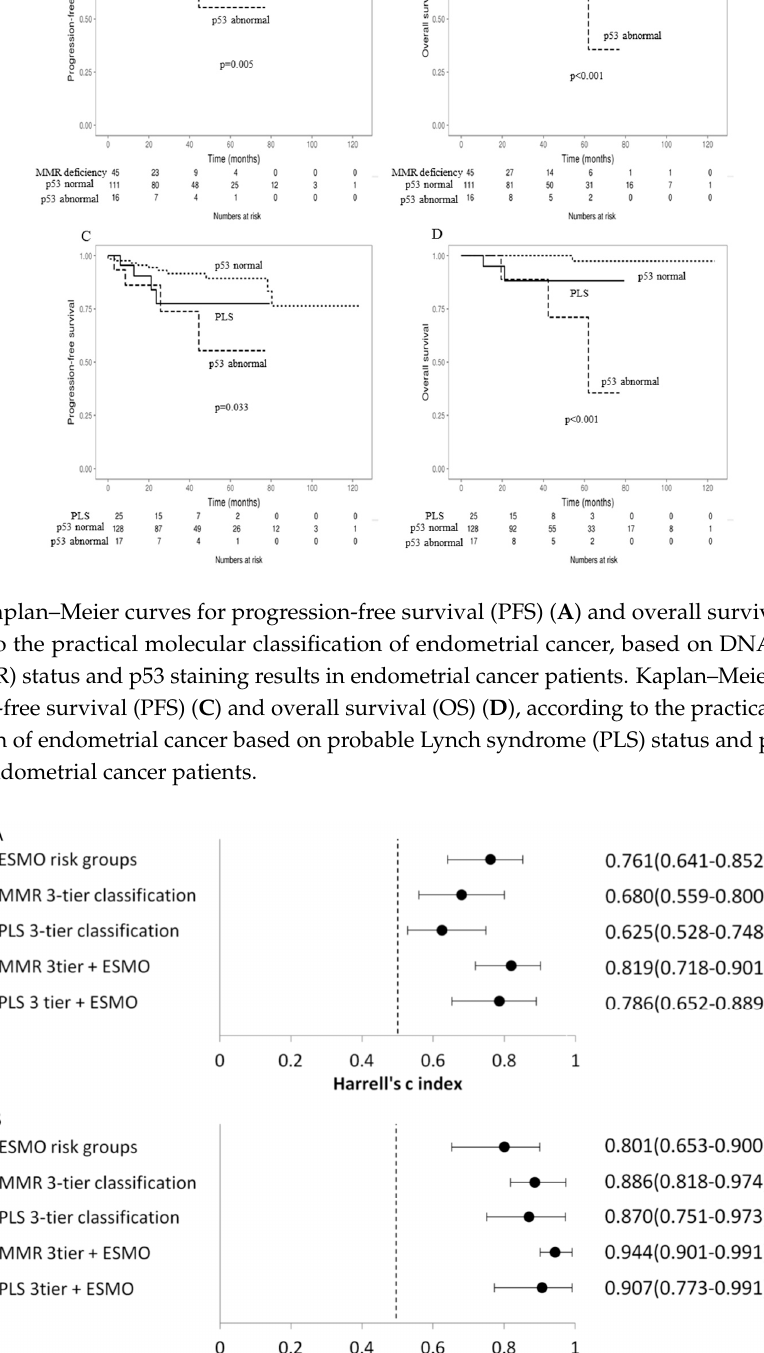
Figure 5. Harrell’s C-index for progression-free survival (PFS) ( A ) and overall survival (OS) ( B ). The combination of European Society of Medical Oncologists (ESMO) risk groups with MMR three-tier classification or PLS three-tier classification improved the predictive ability for both PFS and OS. For OS, MMR three-tier classification or PLS three-tier classification demonstrated a better predictive ability than the ESMO risk groups.